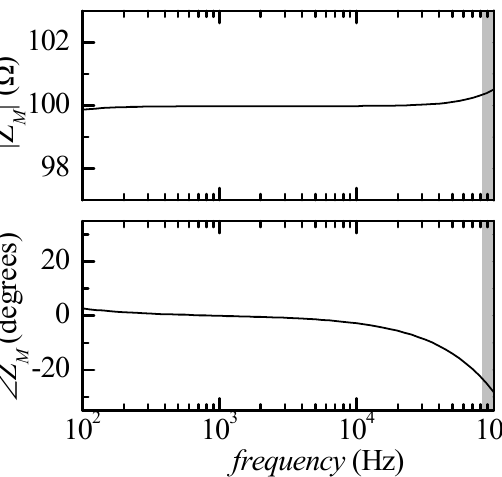
Figure 2. Simulation of the measurement results with Z k = 100 Ω . The grey area indicates the frequency region outside the measuring capability of the audio board being used.